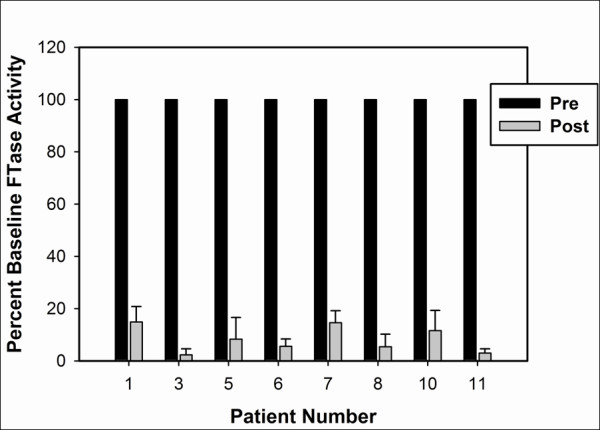
Measurement of FT activity in tumor biopsies pre-treatment compared to on-therapy. Excisional biopsies of cutaneous melanoma metastases obtained prior to therapy with R115777 and during week 7 of therapy were cryopreserved until analysis. FT activity was assessed as described in Materials and Methods. All post-treatment values were statistically significantly inhibited using an unpaired t-test (p<0.01). The assay was performed on single tumors in triplicate, and the error bars represent the variation in the assay for each sample.